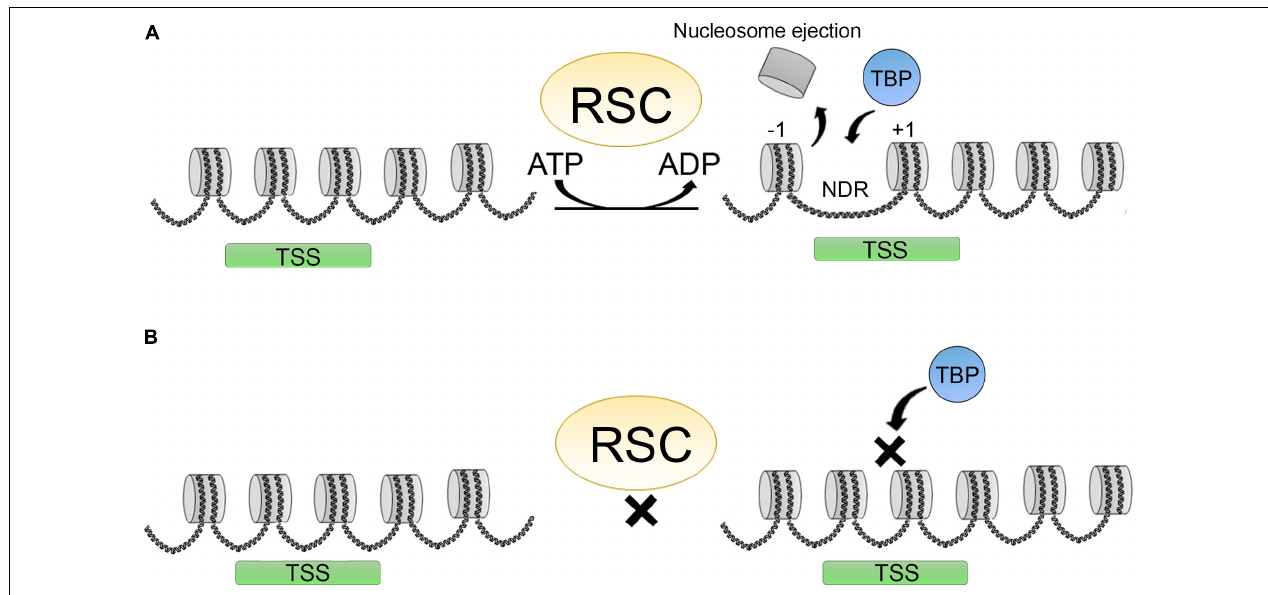
FIGURE 4 | Promoter clearence carried out by the RSC complex. (A) RSC complexes act creating a nucleosome depleted region (NDR) around the TSS shifting the +1 nucleosome position, making this regions more accesible for different factors as TBP (TATA binding protein) thereby promoting transcription initiation. (B) Upon RSC depletion, NDRs around TSS are not formed and this impairs TBP binding and transcription